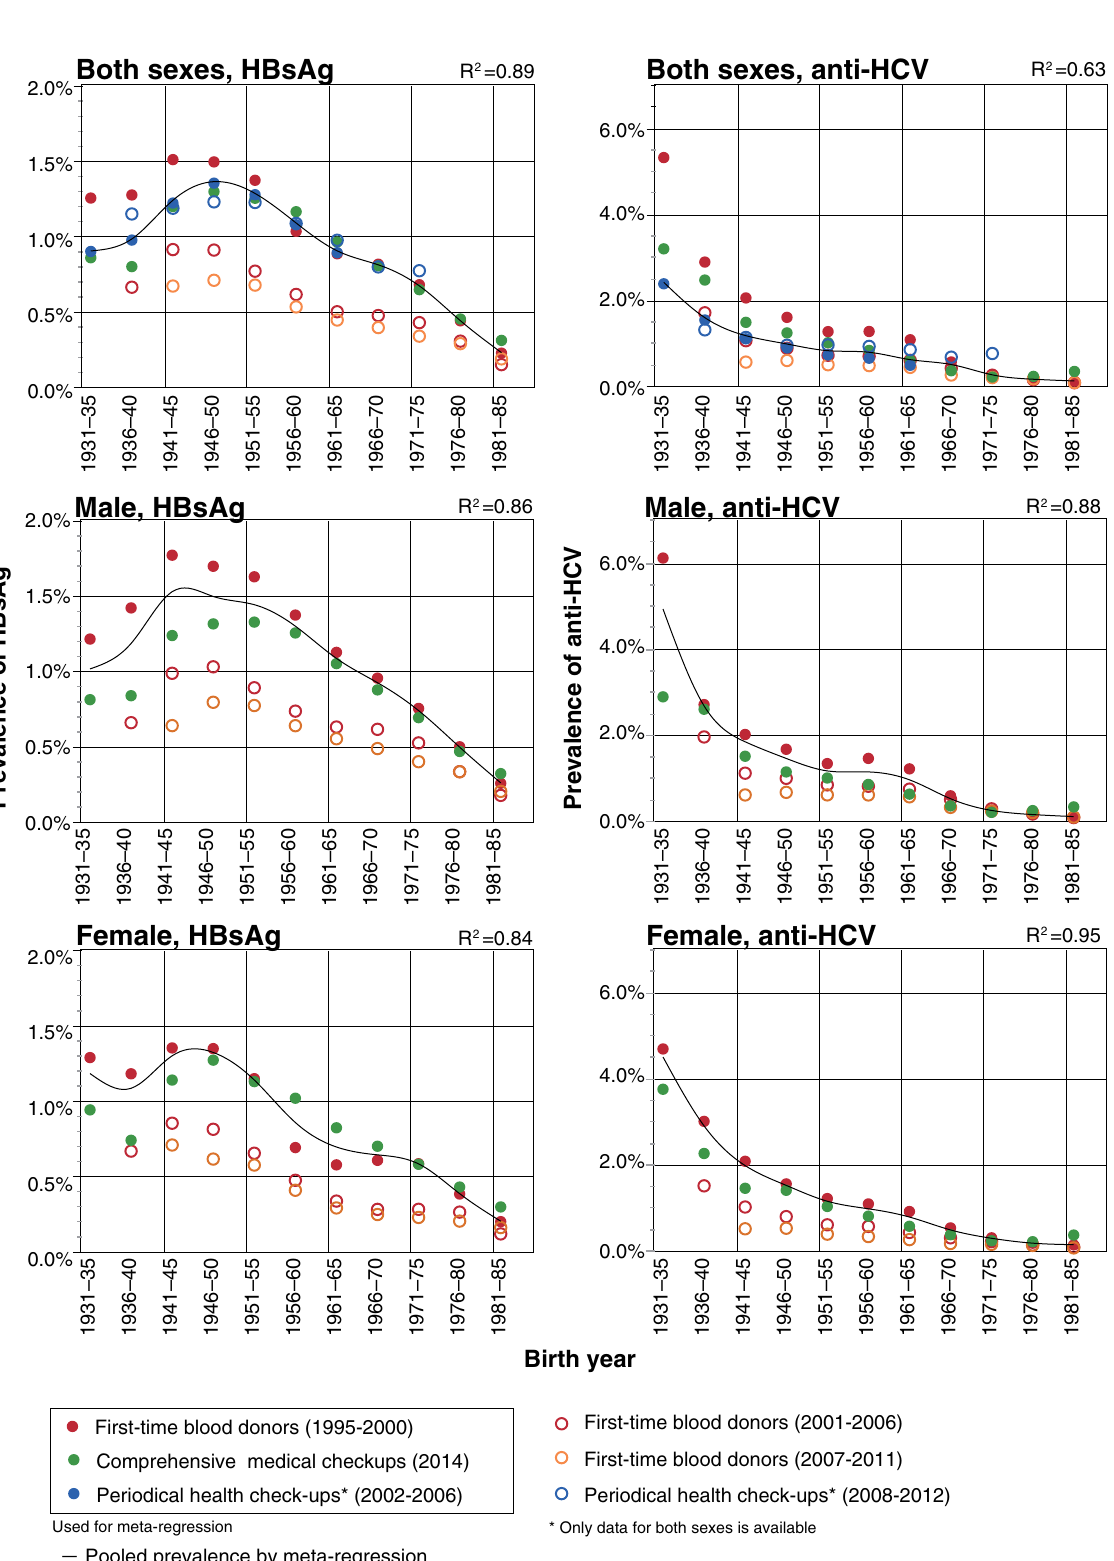
Figure 1. Pooled prevalence of HBsAg and anti-HCV by meta-regression model. This fi gure showed the HBsAg and anti-HCV prevalence of each cohort study and the pooled prevalence of HBsAg and anti-HCV using meta-regression model. The three left sided fi gures represent for HBsAg prevalence while the three right sided ones represent for anti-HCV prevalence. The two fi gures in upper row represent for the overall prevalence while the middle and lower rows indicate for the respective prevalence in male and female respectively. In each fi gure, the earlier cohort studies were showed with red, green and blue dots while the later studies were indicated with red, orange and blue colored rings. The line in every fi gure indicates for the resultant pooled prevalence by meta-regression